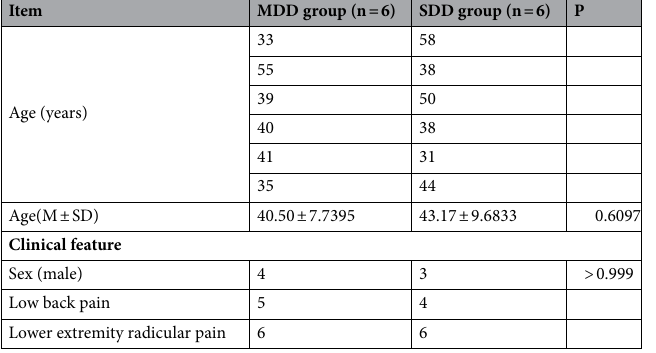
Table 1. Clinical characteristics of